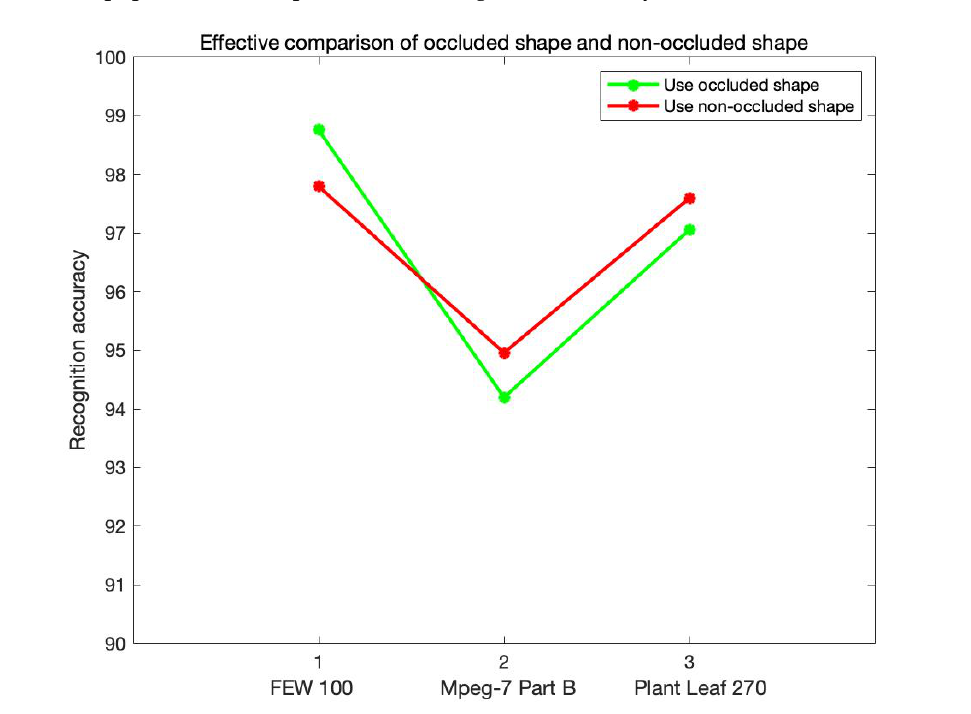
Figure 13. The comparison between occluded shape recognition and non-occluded shape recognition on three datasets, where the green polyline denotes the result of recognition after artificial occlusion, and the red polyline denotes the result of shape recognition without occlusion. It can be seen that the proposed method is still sophisticated for non-occluded shape recognition, and shows high recognition